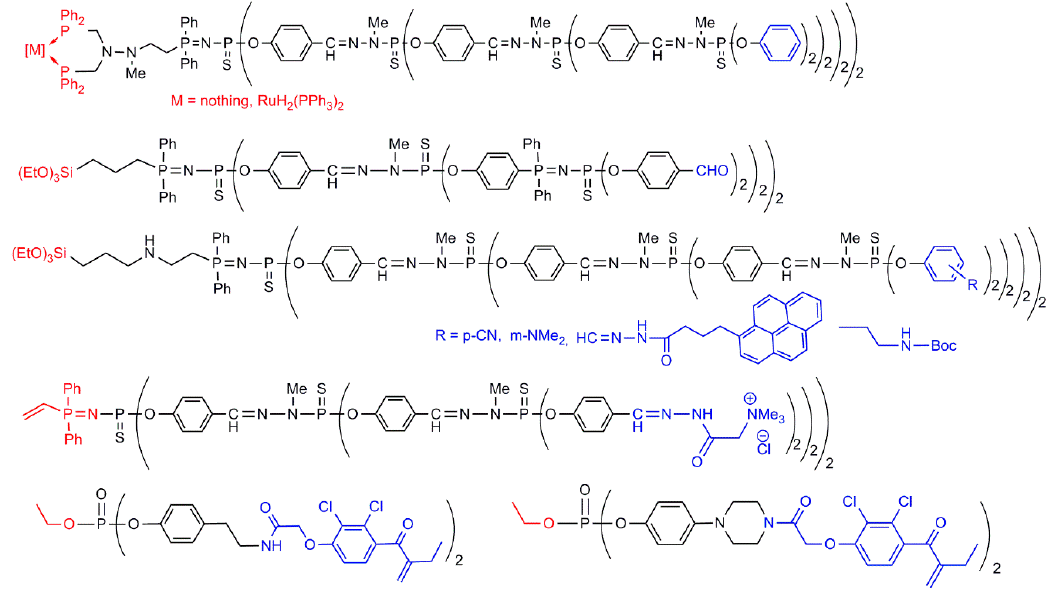
Figure 7. Examples of dendrons synthesized for applied purposes. From top to bottom : dendron for catalysis, Et 3 Si group as core for the grafting to silica, vinyl group for the grafting to polystyrene nanoparticles, and two small dendrons with two ethacrynic derivatives as terminal functions, tested as anti-cancer agents.